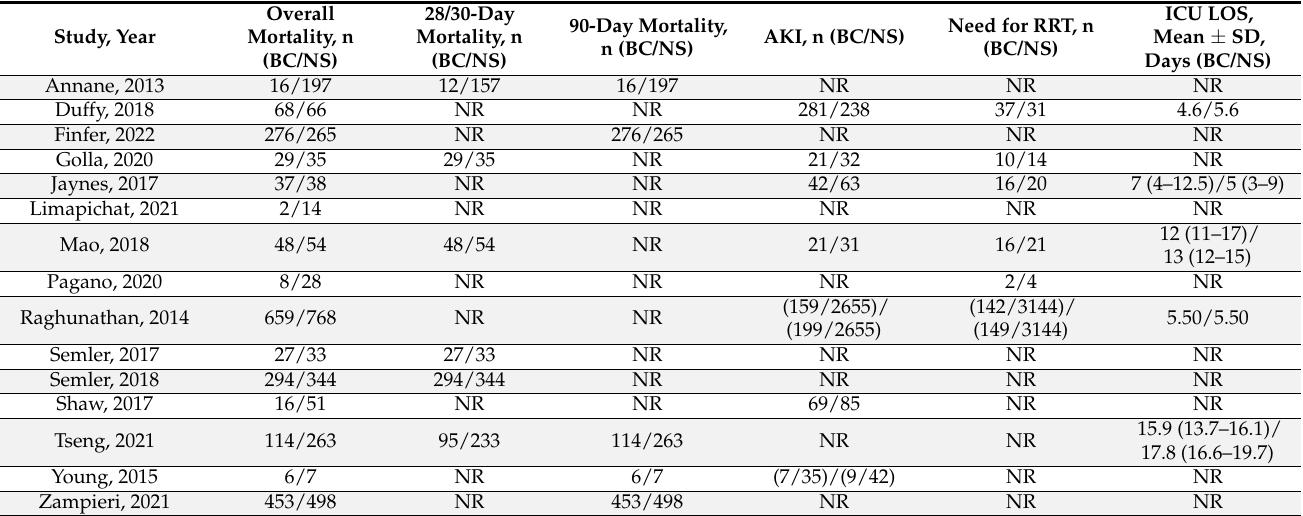
Table 2. Outcomes of the included studies in the meta-analysis.